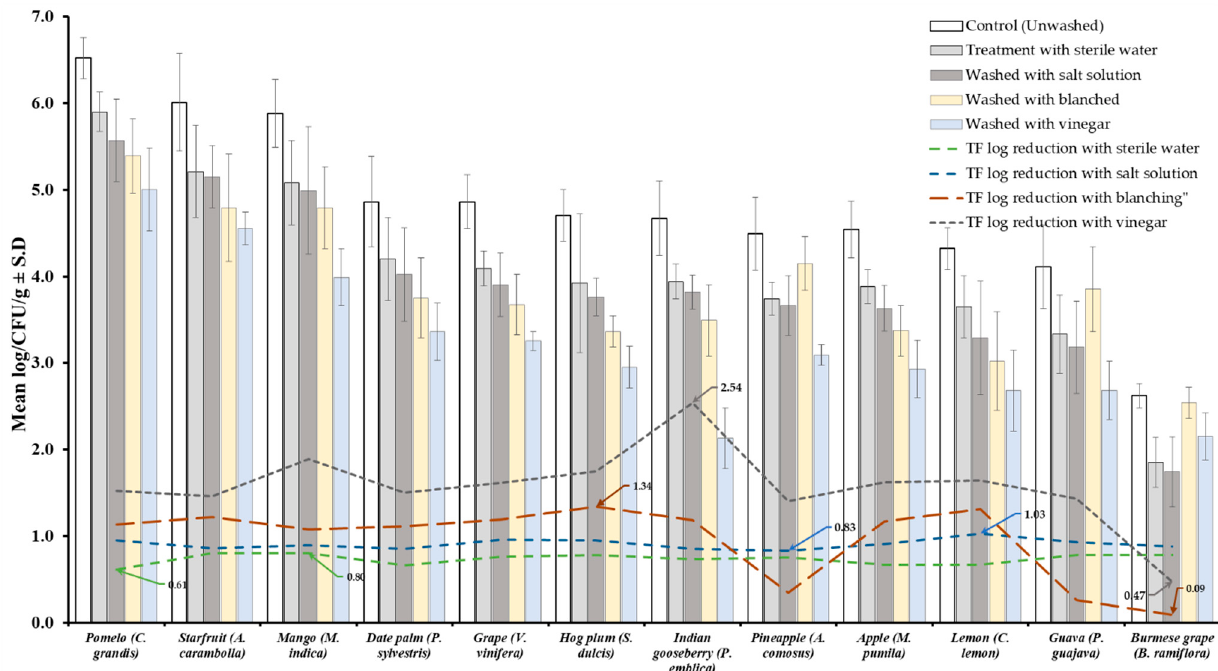
Figure 2. Four different treatments (sterile water, salt solution, blanched, and vinegar) were observed on total viable bac- terial load (TVBC) decontamination from the surface of 12 different types of fruit. Data are mean ( n = 4) ± standard devia- tion.